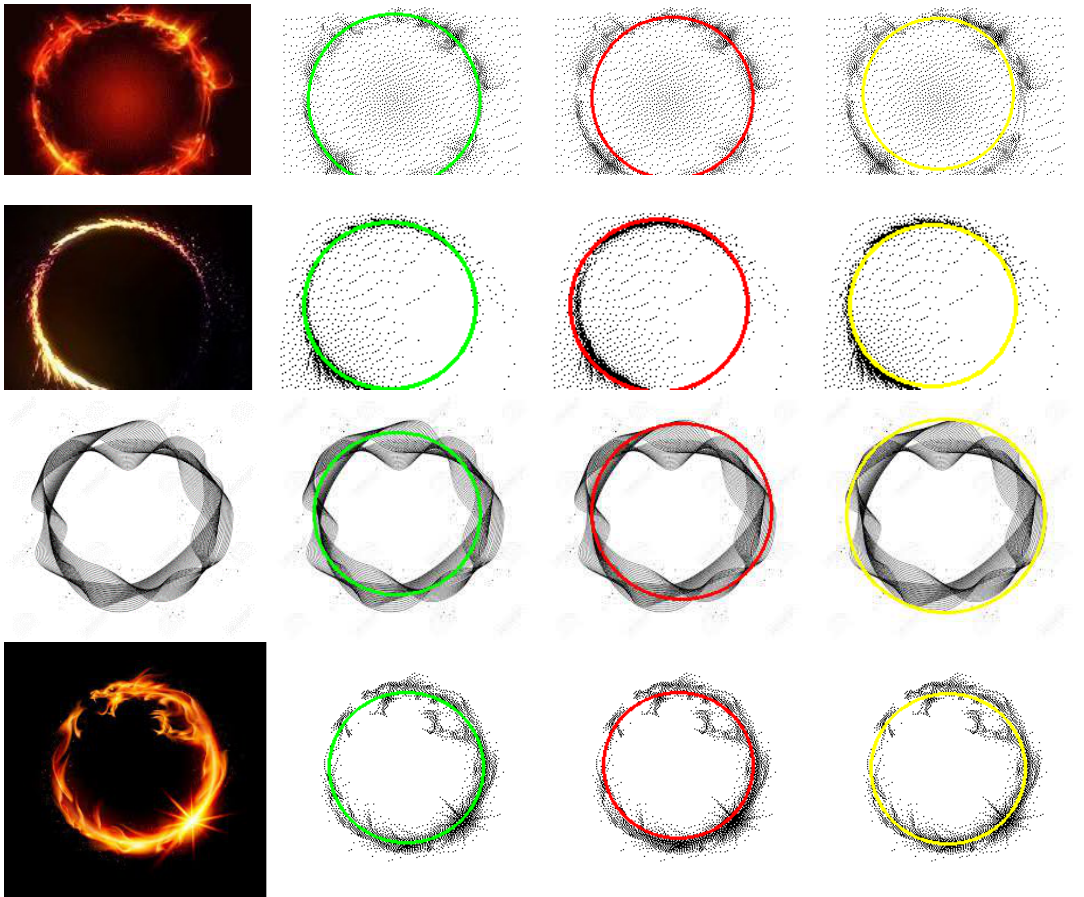
Figure 7. ( Left) An original 2 D images. ( green ) A result for circle detection over real 2 D images using our coreset algorithm. ( red ) A result for circle detection using “Improved RANSAC” algorithm. ( yellow ) A result for circle detection using “OpenCV”, a widespread open source library